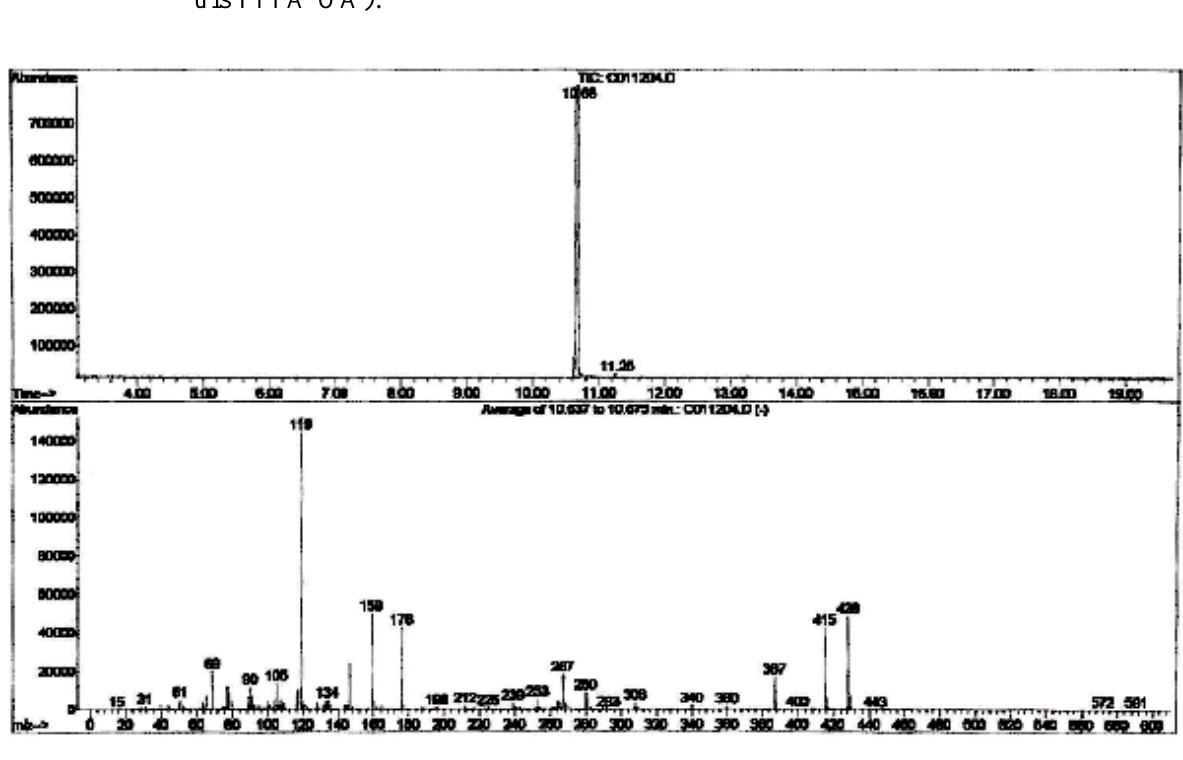
Figure 3. TIC (upper) and Mass (lower) Spectra of OA derivative products (60 ° C, 1hr with 30 µ L PFPA). Oven temperature program: see Section 2.4.2. (R